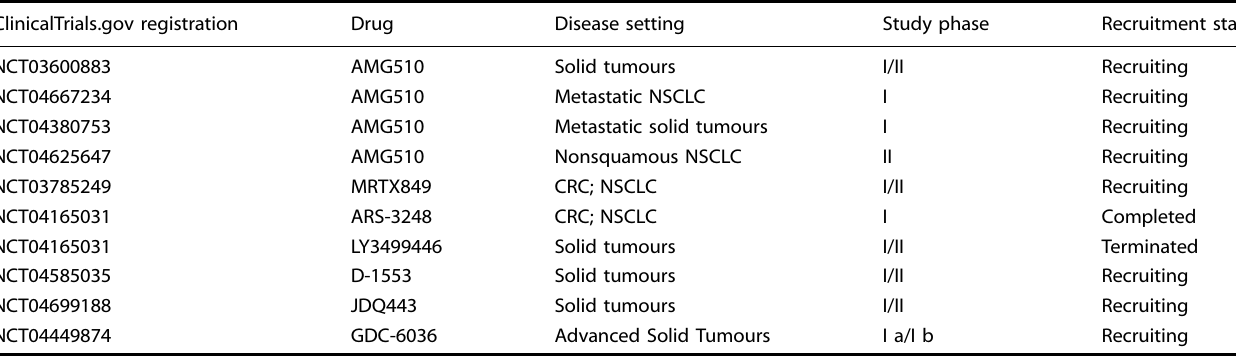
Table 2. The clinical development of KRAS (G12C) inhibitors ClinicalTrials.gov registration